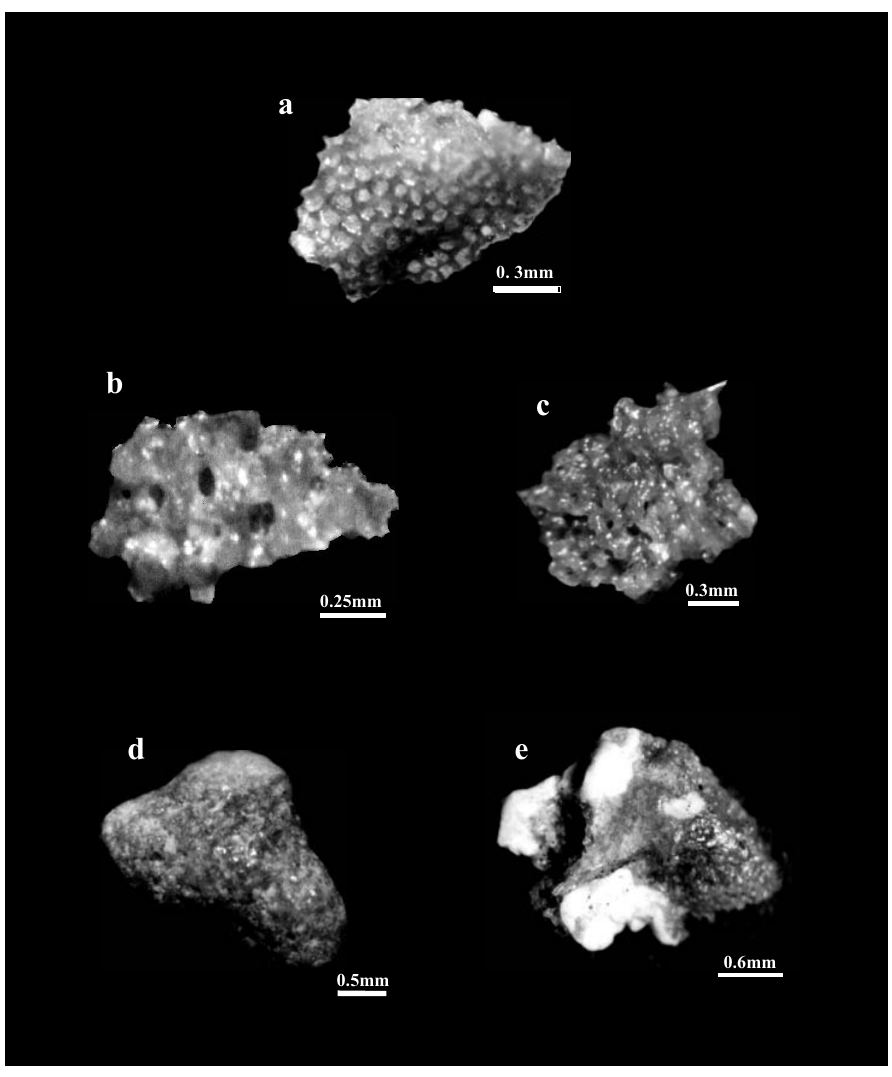
Fig. 4 – Surface features of Homotrema rubrum fragments: a. well preserved chambers, scale 1 cm = 0.3 mm; b. sharp pointed grain, scale 1 cm = 0.25 mm; c. hollowed chambers, scale 1 cm = 0.3 mm; d. polished grain, scale 1 cm = 0.5 mm; e. Homotrema encrusting in coralline algae fragment, scale 1 cm = 0.6